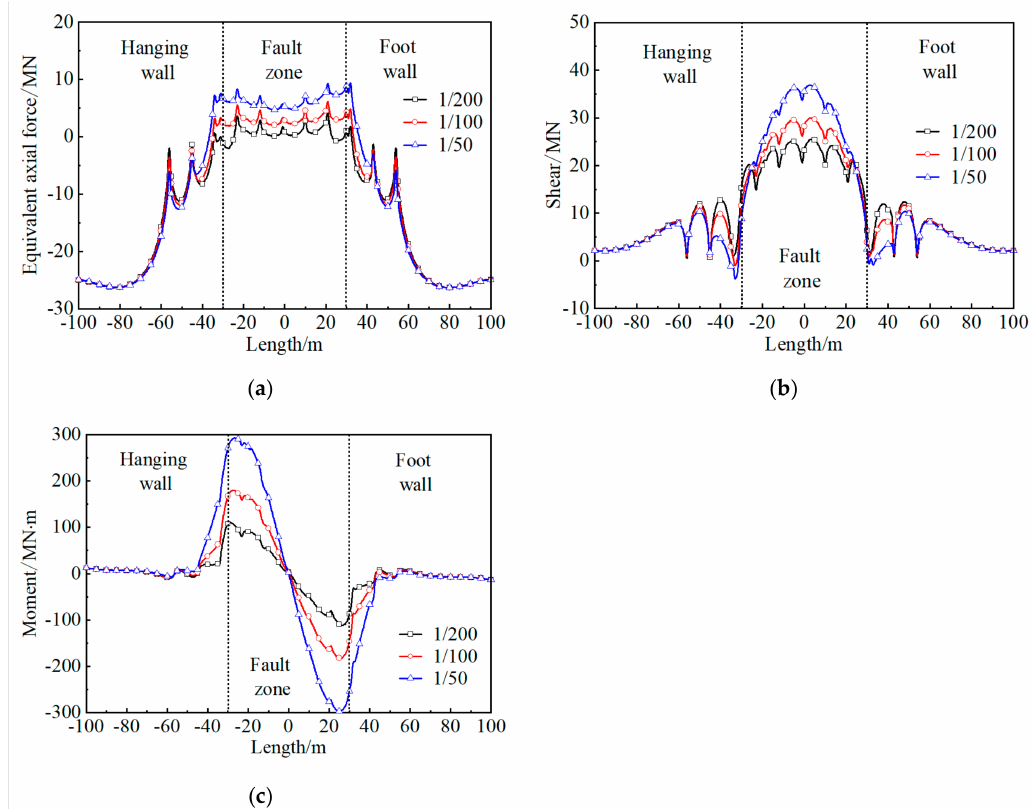
Figure 21. Distribution of internal force and moment for a tunnel under different flexible joint stiffness. ( a ) equivalent axial force; ( b ) shear; ( c )